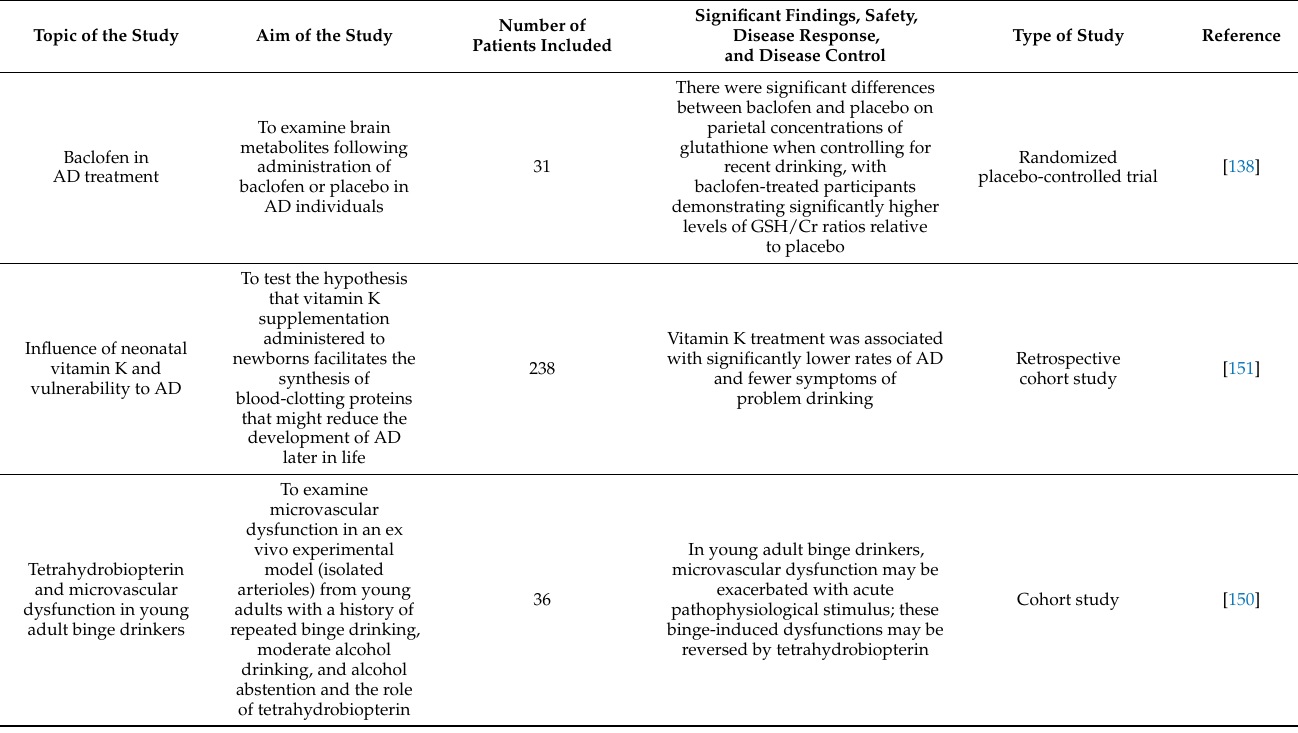
Table 6. Published clinical studies on potential therapeutic agents in